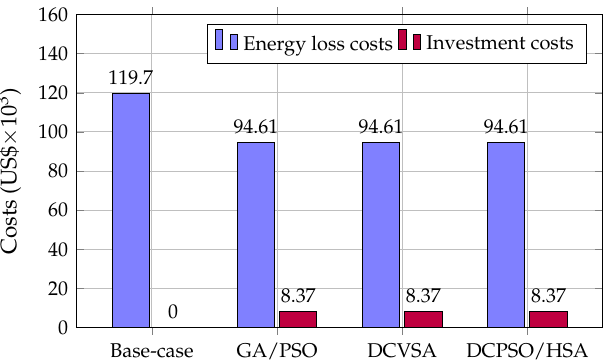
Figure 5. Comparison of operating and investment costs in the 69-bus